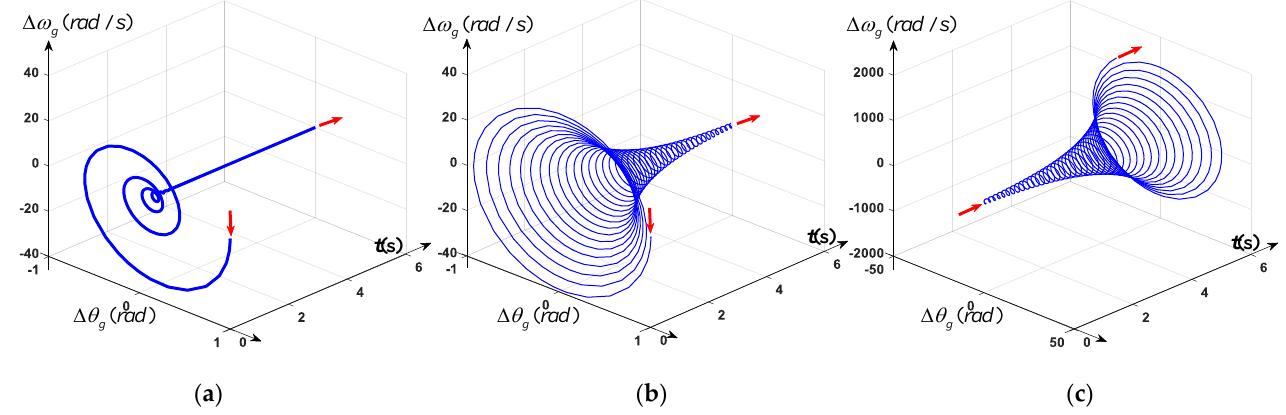
Figure 18. Internal voltage dynamics with different values of D f : ( a ) D f = 3.5; ( b ) D f = 0.1; ( c ) D f = −1 .5. Table 2. Synchronverter specifications.